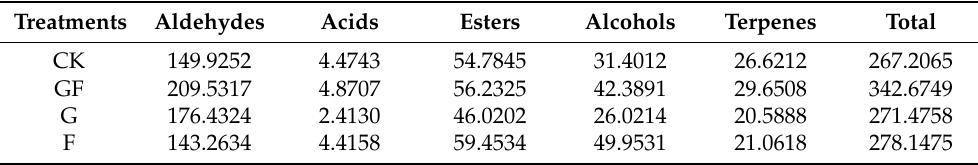
Table 4. Total concentrations ( µ g/L) of each aroma compound in grapes at harvest from plants subject to the four different